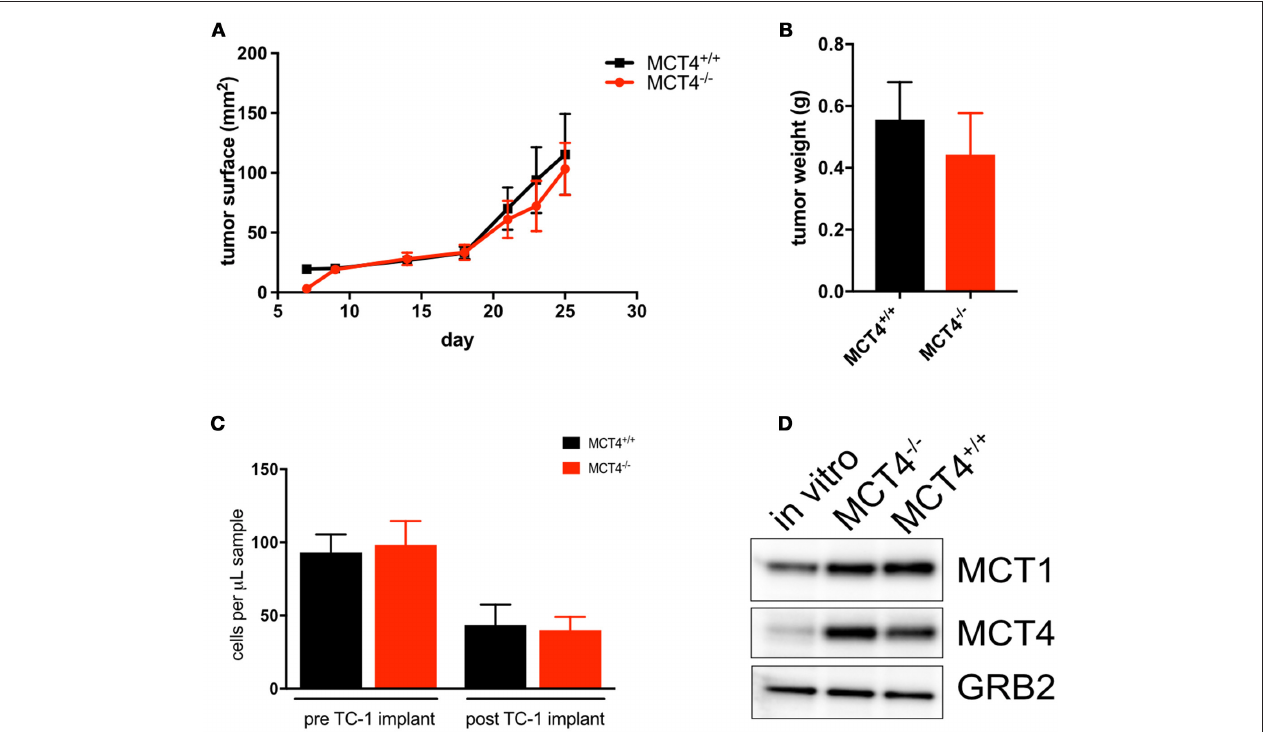
FIGURE 7 | MCT4 expression in syngeneic tumor cells is sufficient for tumor growth. Growth curve of TC-1 tumors in MCT4 − / − and wild type mice ( n = 10 per group) (A) and average tumor weight at sacrifice (B) . Quantification of total monocytes in peripheral blood of wild type and MCT4 − / − animals before and after transplantation ( n = 5 per group) (C) . Western blot analysis of lysates prepared from TC-1 cancer cells in vitro and TC-1 tumors grown in MCT4 − / − and wild type mice for MCT1 and MCT4 using GRB2 as a loading control (D)